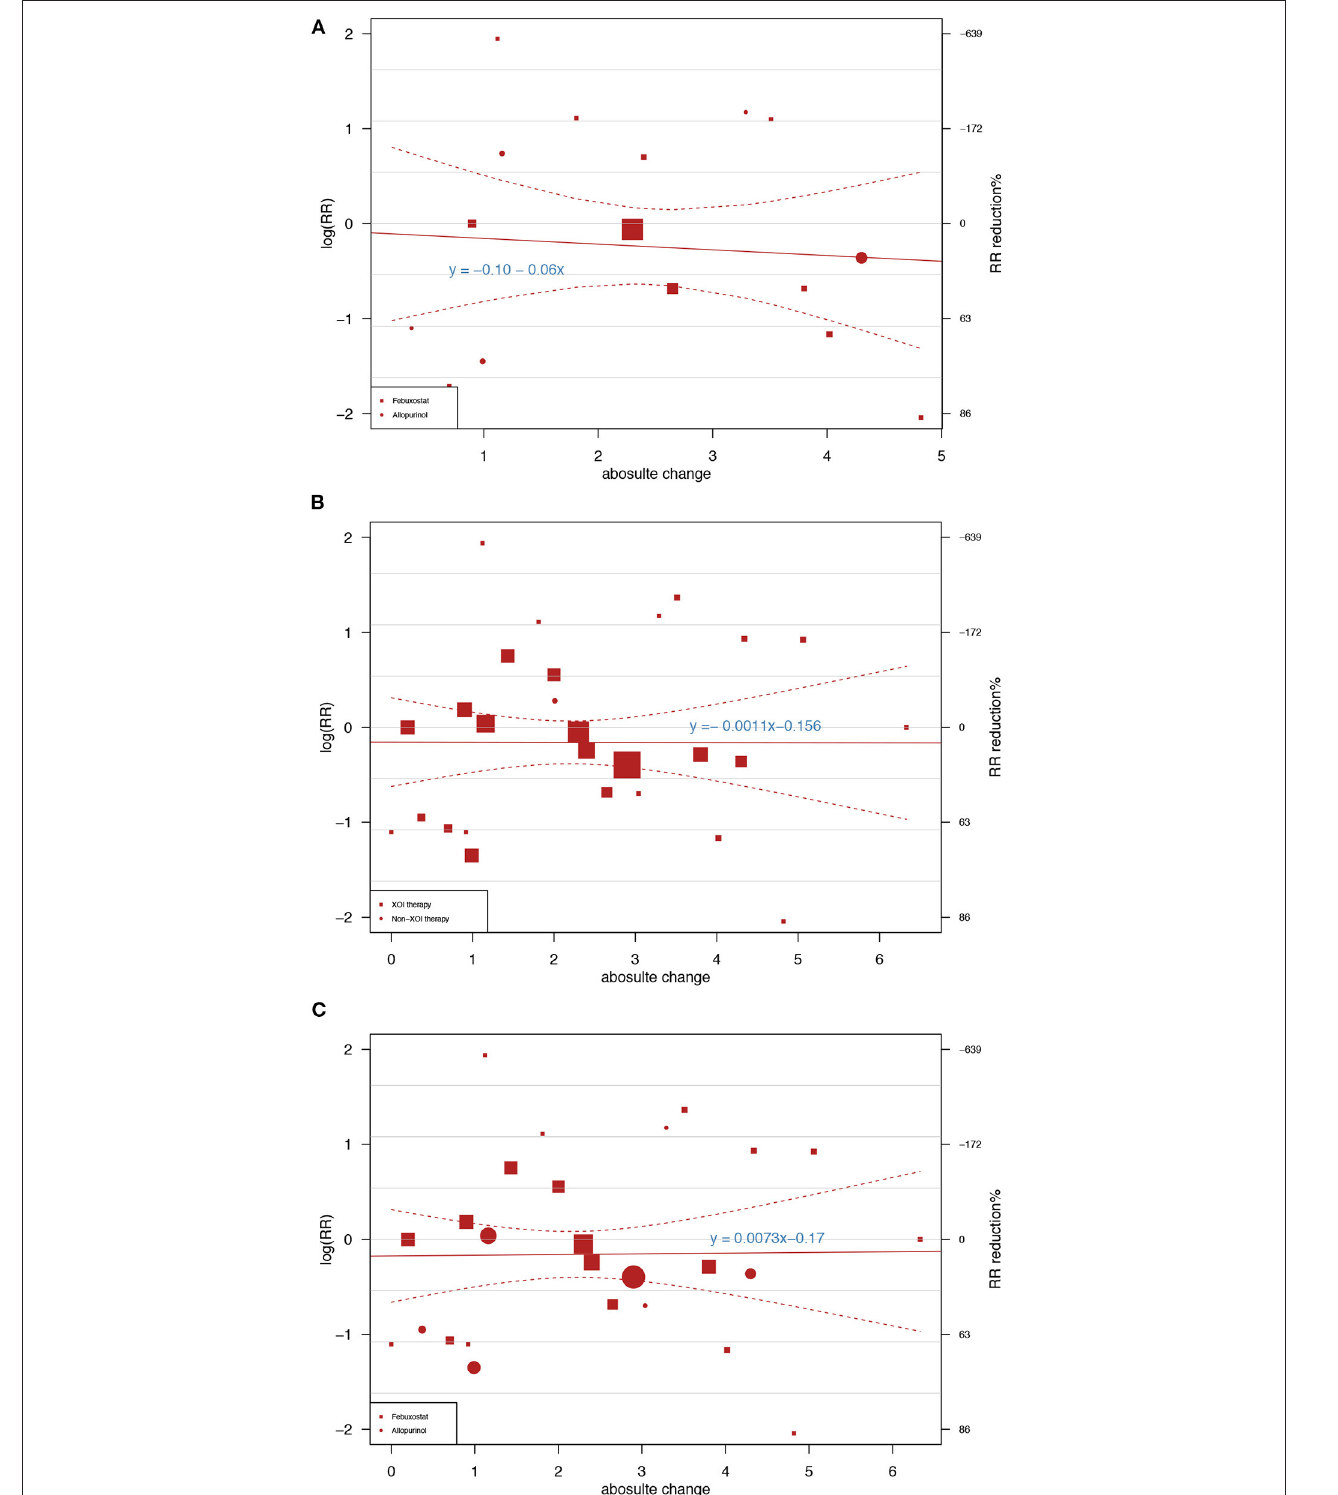
FIGURE 2 | Meta-regression showing the association between the achieved uric acid (UA) differences between groups and the risk ratios of major adverse cardiovascular events (MACEs) and cardiovascular events (CVEs). The square and circle sizes are proportional to the study weight. The equation shown in the figure represents the meta-regression slope, which is drawn with a solid line, and the 95% confidence intervals, which are indicated by the dashed lines. (A) Association between UA reduction caused by xanthine oxidase inhibitors (XOIs) and MACEs. (B) Association between UA reduction caused by different UA-lowering medicines and CVEs. (C) Association between UA reduction caused by XOIs and